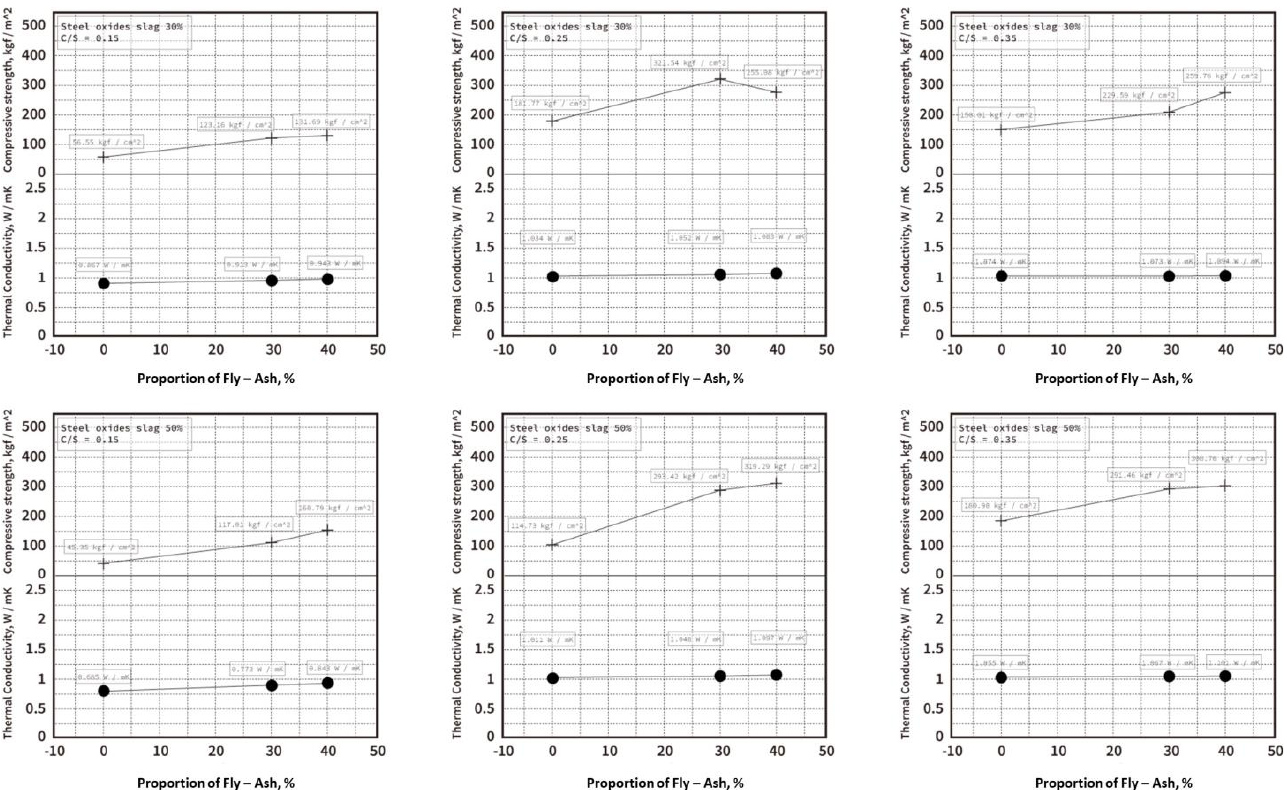
Figure 13. Compressive strength and thermal conductivity of EAF oxidizing slag specimens with different ash replacements.